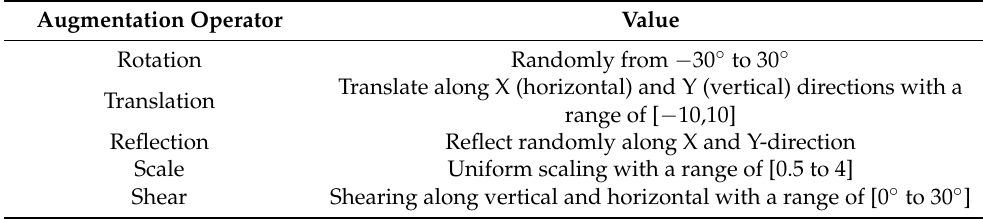
Table 2. Parameter settings of the proposed augmentation